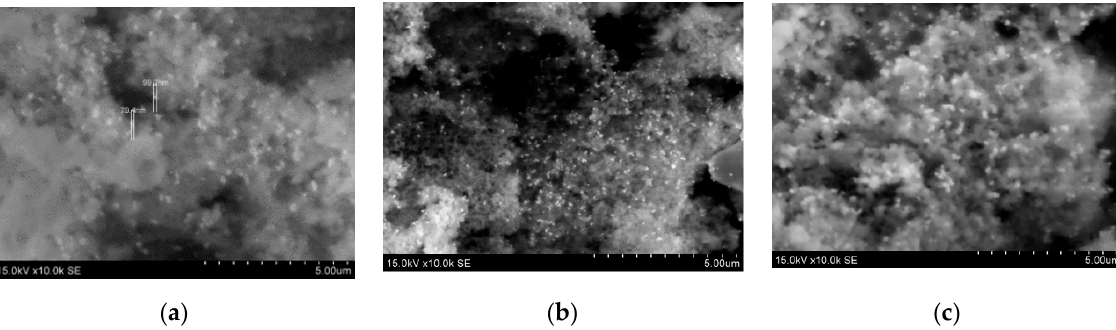
Figure 3. SEM images of silver nanoparticles synthesized using extracts of ( a ) A. absinthium , ( b ) H. lupulus, and ( c ) T. vulgaris.